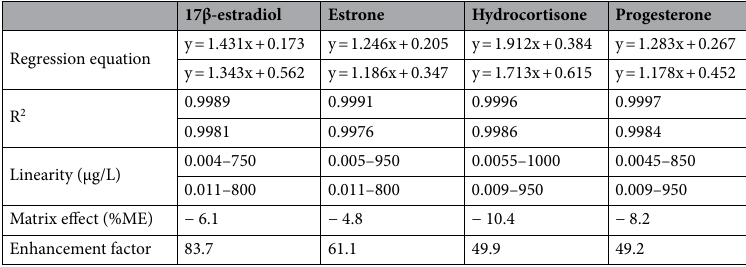
Table 1. Analytical characteristics of the developed method.